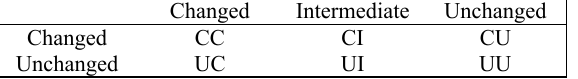
Table 4. Relationship matrix between result and reference.